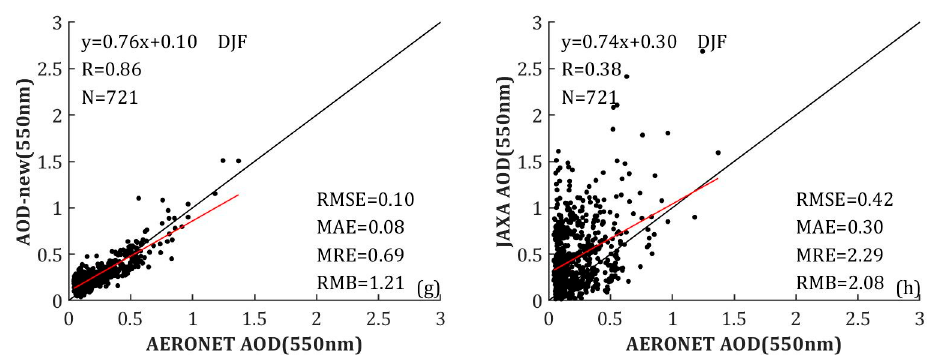
Figure 8. The scatter plots of AOD validation in different seasons: ( a , b ) Spring; ( c , d ) summer; ( e , f ) autumn; ( g , h ) winter. Left: AOD-new; right: JAXA AOD.